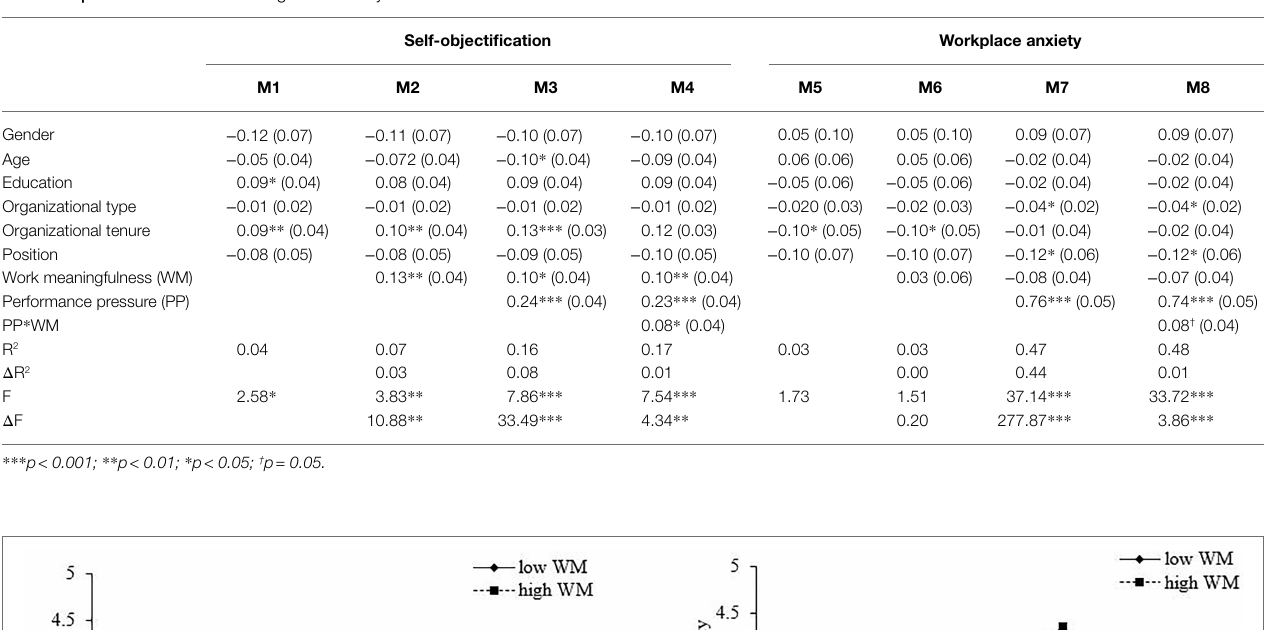
TABLE 3 | Results of hierarchical regression